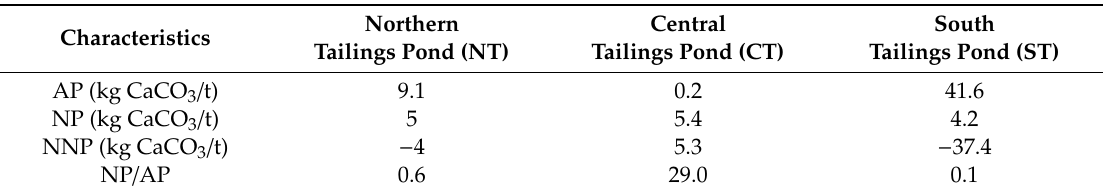
Table 5. Static test results of the Tiouit